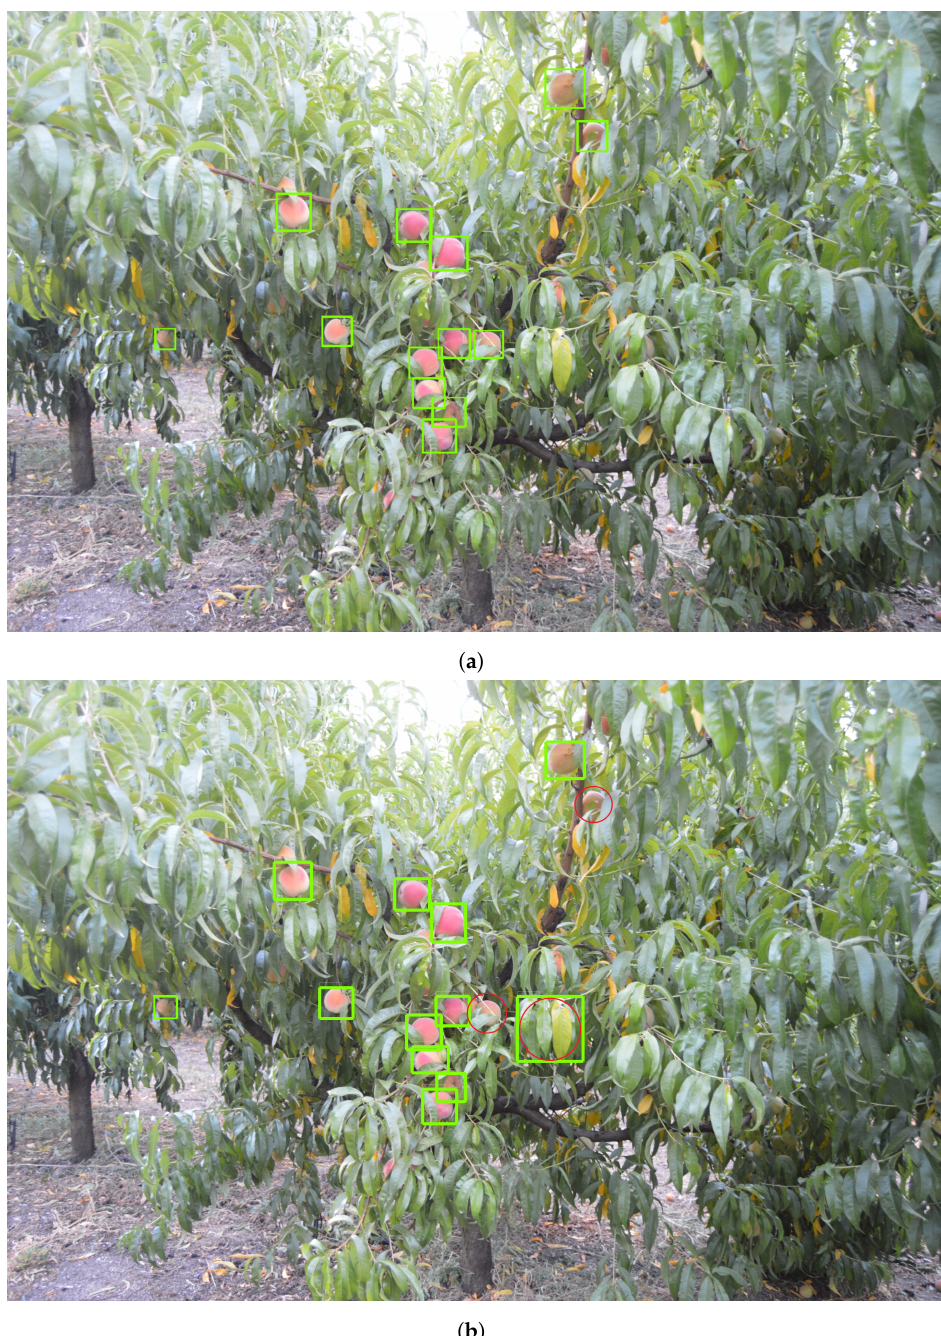
Figure 13. Test results in a different orchard (sample-4): ( a ) shows a test image and its manually annotated fruits; ( b ) shows the predicted fruits detection by the model. The green rectangular boxes are corrected detections, and the red circles are illustrative missing